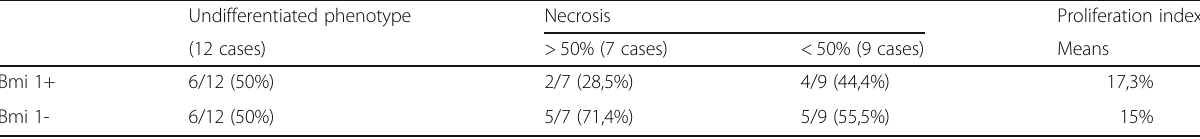
Table 3 Frequency of undifferentiated phenotype, necrosis and Ki-67 proliferation index in tumors with and without Bmi-1 expression